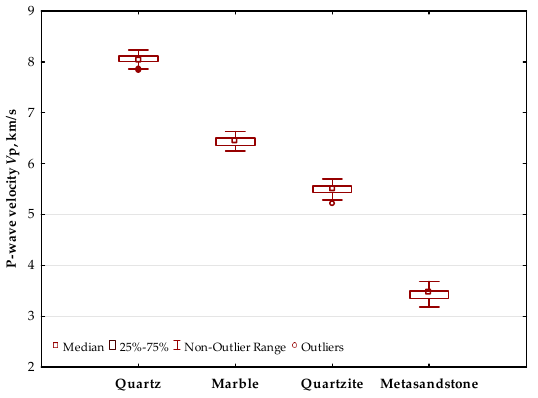
Figure 6. P-wave velocity of all materials used.